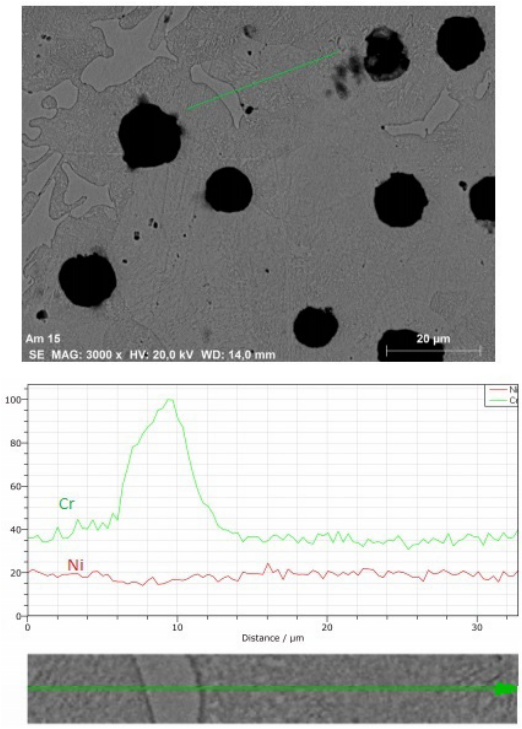
Figure 23. Mo/Cu EDS profile.